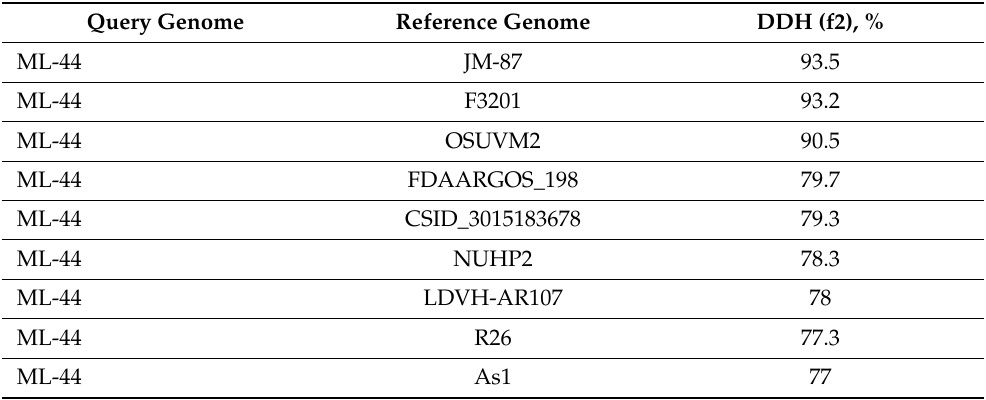
Table 2. Genome-to-genome distance calculator (GGDC) analysis for ML-44 strain and other related E. anophelis